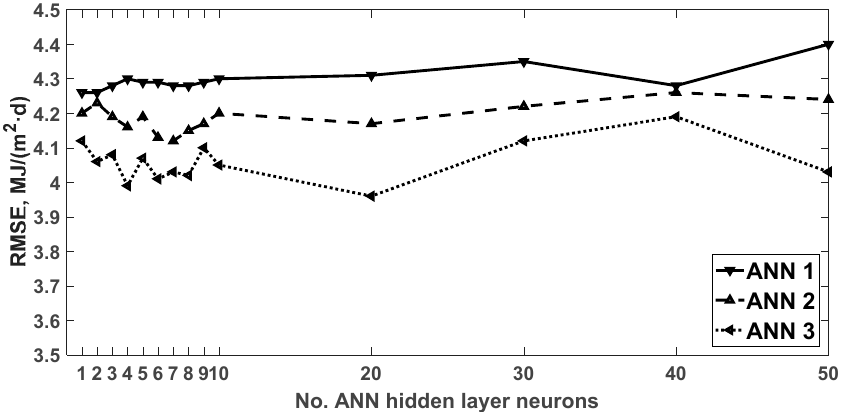
Figure 2. Horizontal daily global solar irradiation effectiveness of prediction the day after simulated with the ANN 1, ANN 2, and ANN 3 models, compared with the variable measured values, in 2011, as a function of the neurons number in the hidden layer. RMSE: root mean square error (MJ/(m 2 ·d)). Furthermore, the results were obtained with the simulation by using ANN 4, ANN 5, and ANN